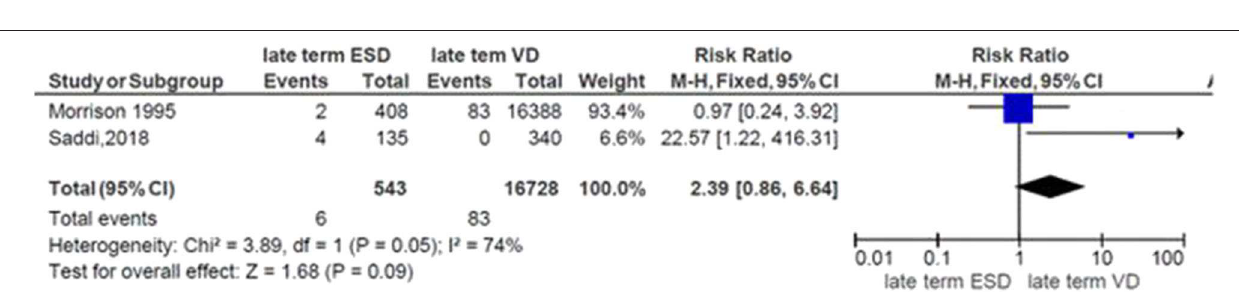
FIGURE 5 | Risk of neonatal respiratory morbidity at 39 weeks of gestation and mode of delivery, 2019.